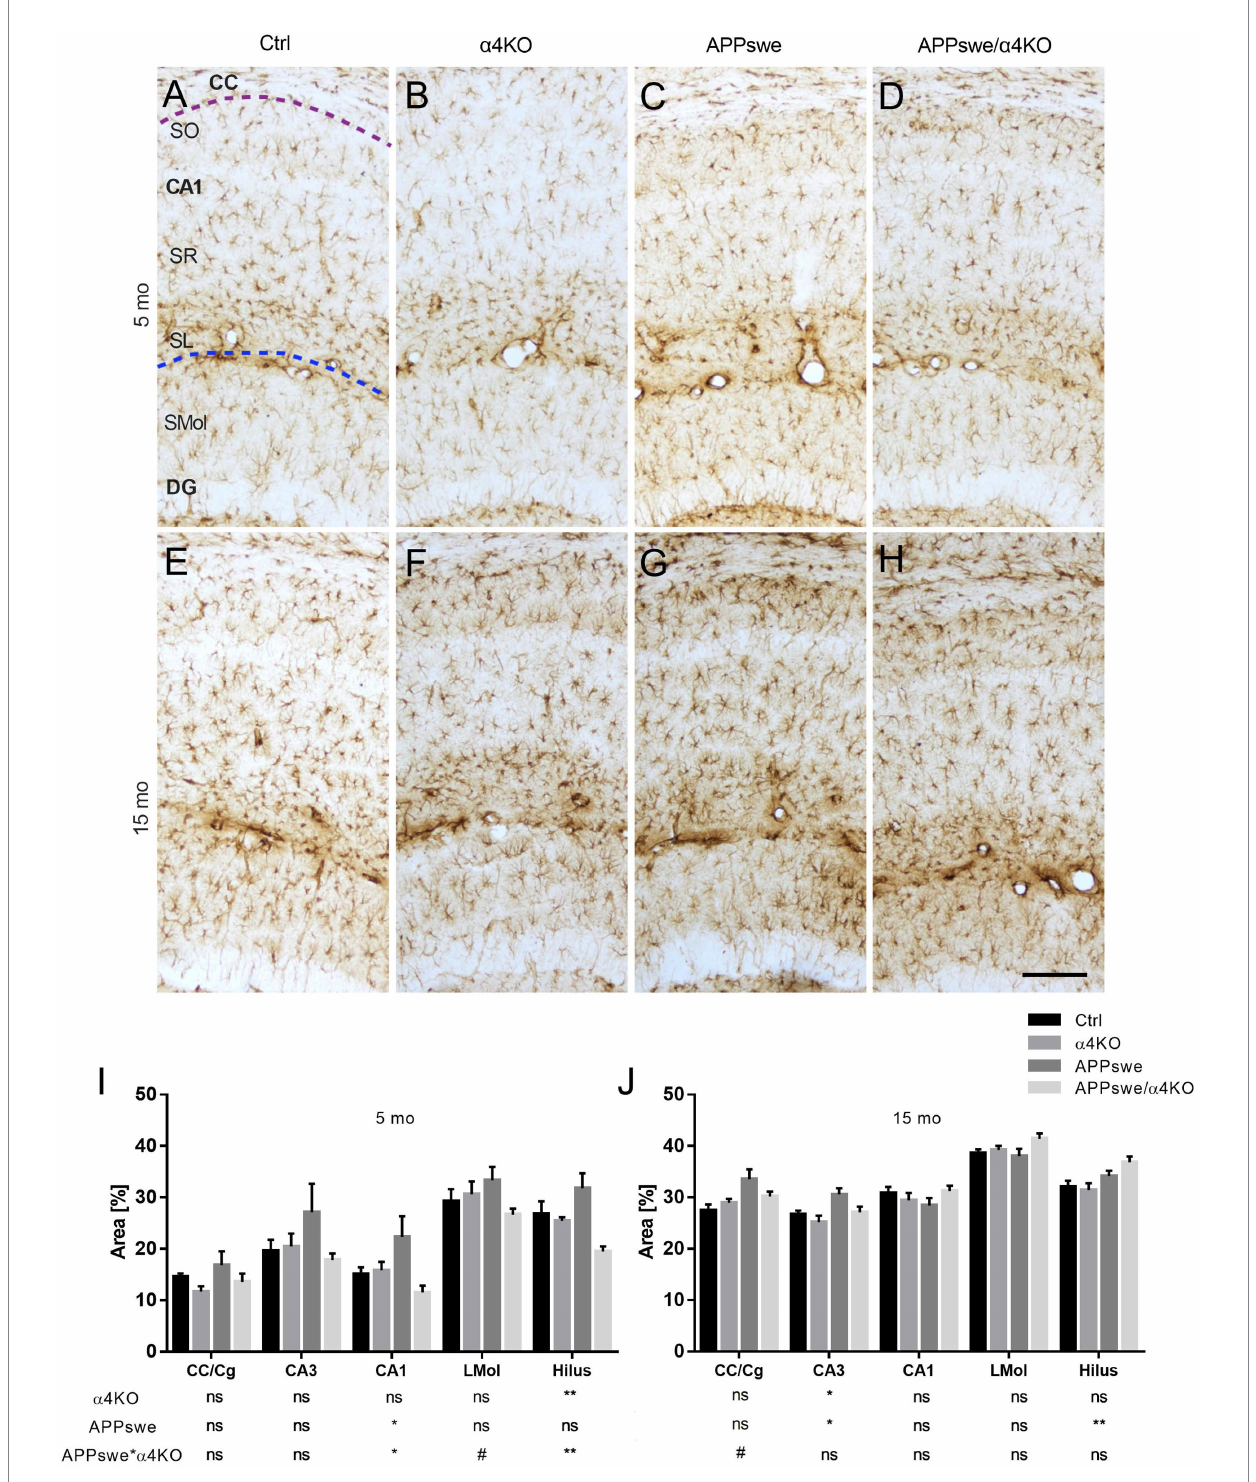
FIGURE 5 Quantitative analysis of GFAP immunoreactivity in 5 and 15 mo mice. (A–H) Representative images of GFAP+ immunoreactivity in 5 mo (A–D) and 15 mo (E–H) mice. Astrogliosis was analyzed in the Hip of Ctrl (A,E) , α 4KO (B,F) , APPswe (C,G) , and APPswe/ α 4KO (D,H) mice. Scale bar = 100 μ m. (I,J) Quantitative analysis of GFAP ir in CC, Cg and Hip in 5 (I) and 15 (J) mo mice. Data are shown as mean ± SEM and compared by two-way ANOVA test, * p < 0.05, ** p < 0.01, # 0.10 > p > 0.05 as trend for a significant difference. CC, corpus callosum; Cg, cingulate cortex; CA1, Cornu Ammonis 1 of hippocampus; LMol, stratum